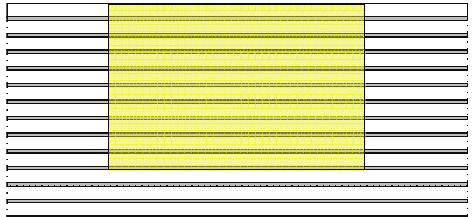
Figure 2: The layered material with boundary surface parallel to interfaces.